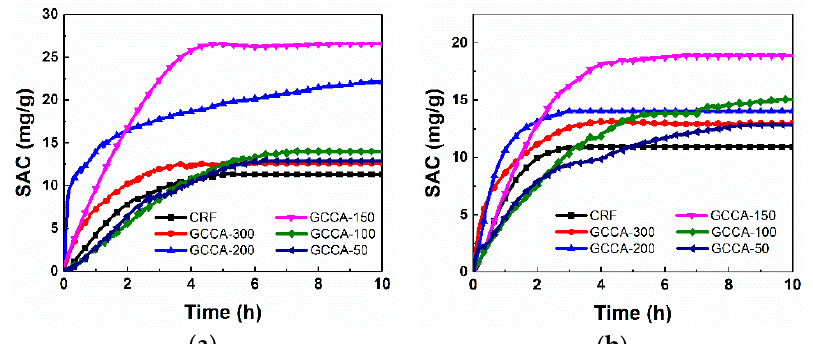
Figure 6. Salt adsorption capacities for the CRF and GCCA electrodes in NaCl solution with the initial concentrations of ( a ) 500 mg/L and ( b ) 250 mg/L.